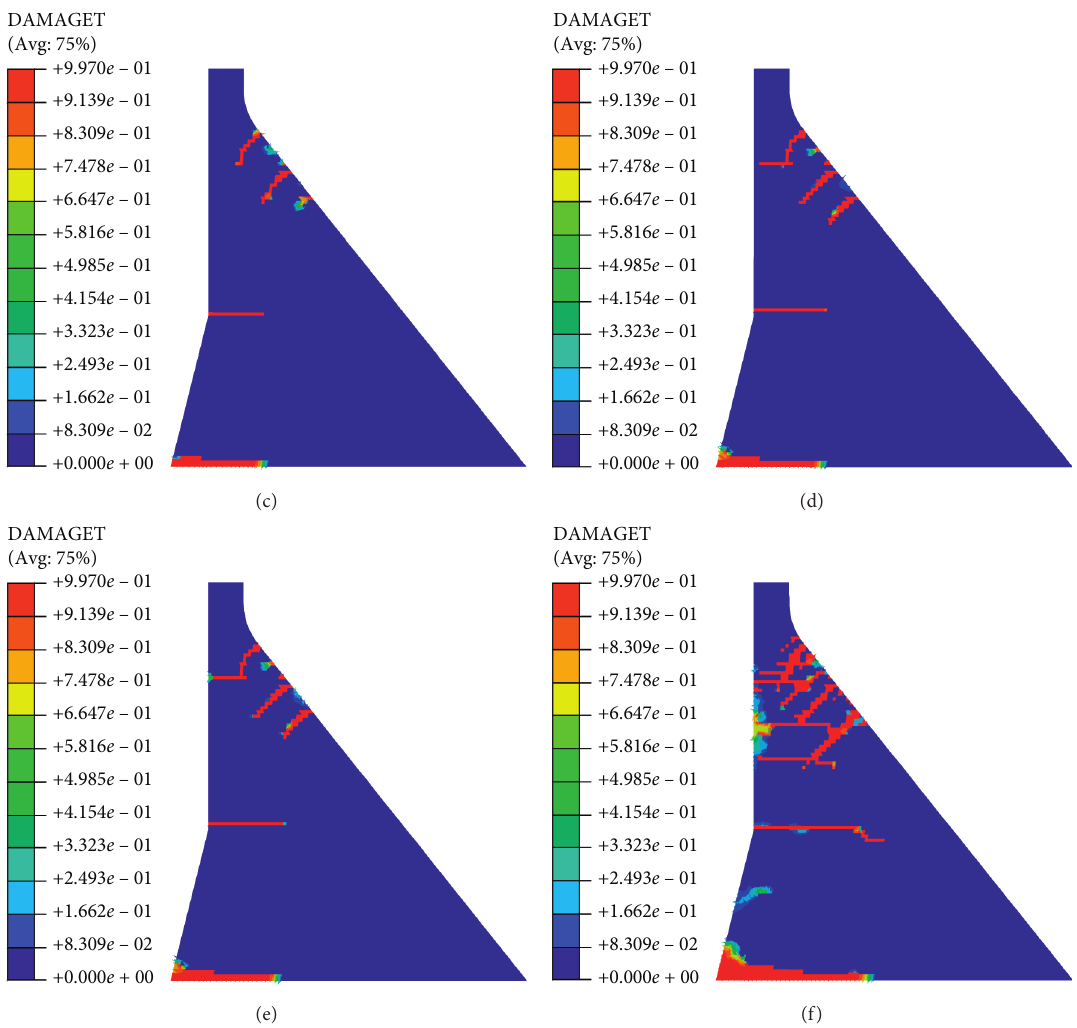
Figure 8: Damage rupture process only considering the tension damage under different earthquake overload coefficients. (a) 1.0. (b) 1.2. (c)